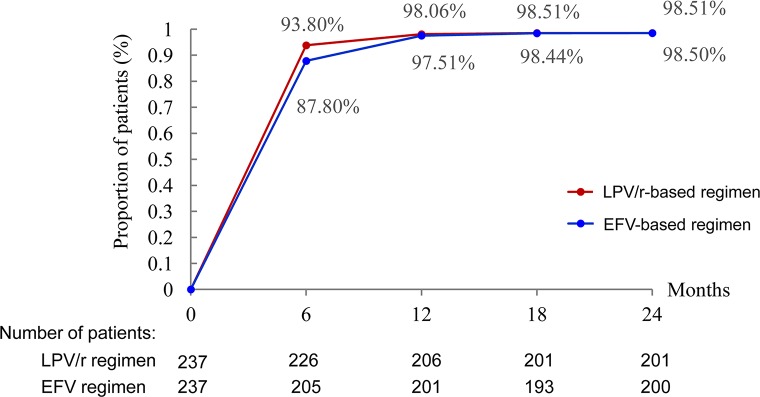
Proportion of patients with HIV RNA <40 copies/ml. *P < 0.05, the difference in the proportion of patients with HIV RNA <40 copies/ml was significant in χ2 tests.